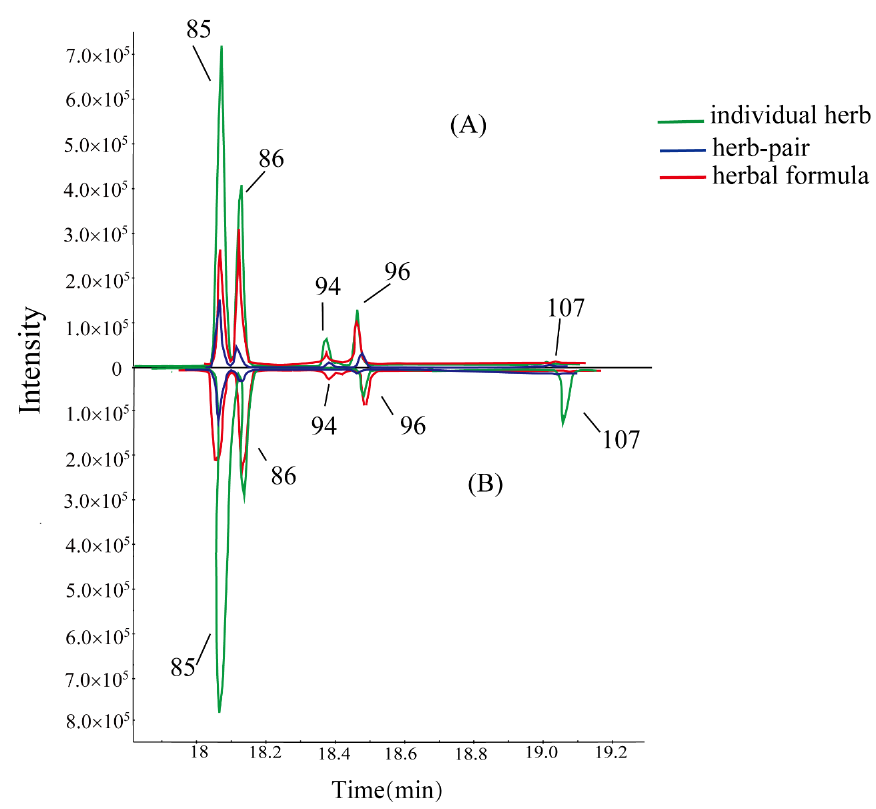
Figure 5. Comparison on intensity of five isomers of Saikosaponins in BR, BR-PRA herb-pair, and SNS ( B ). Comparison on intensity of five isomers of Saikosaponins in VPBR, VPBR-VPPRA herb-pair, and SNS-containing VPBR and VPPRA ( A